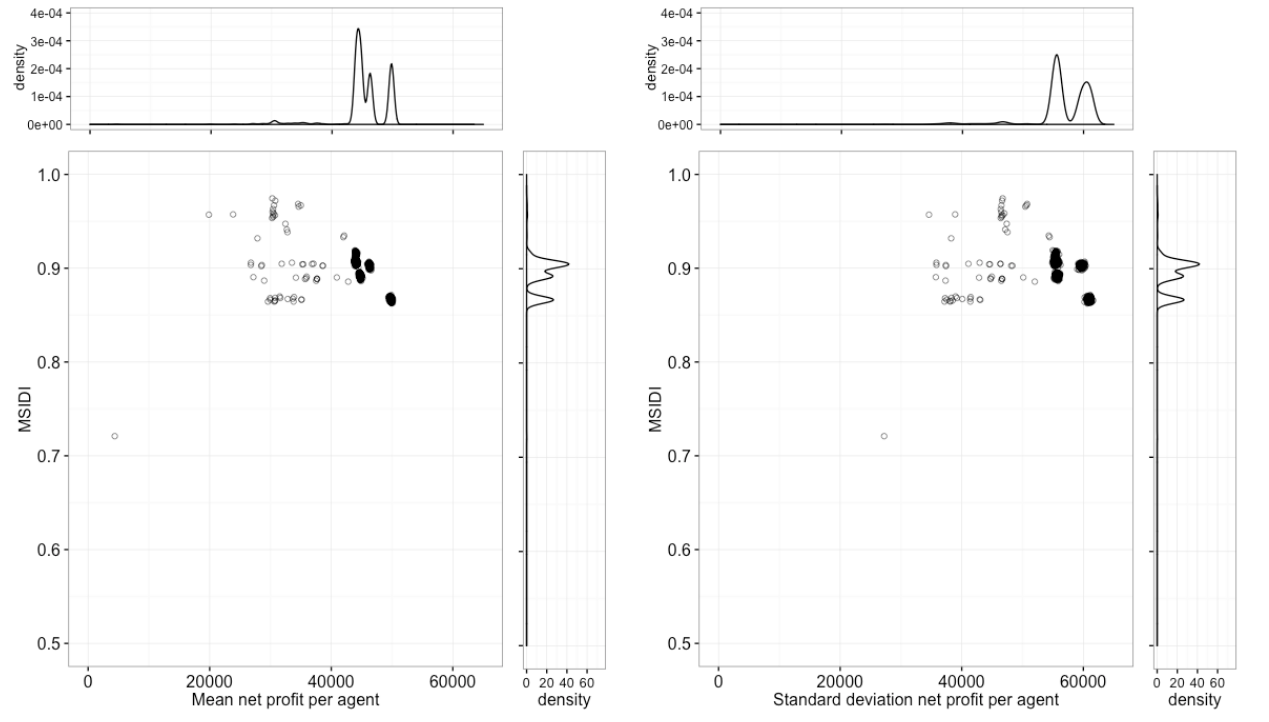
Fig. 8 . Two different stability landscapes for Scenario 12, created with mean profitability (left) and the standard deviation of profitability (right). While variable selection might affect state space configuration, in this case the spaces have similar structures due to their high correlation ( r = 0.95). This suggests that in model runs where mean profitability is higher after a perturbation, farmer outcomes are highly skewed and less equitable because the larger operators were resilient. (MSIDI: Modified Simpson